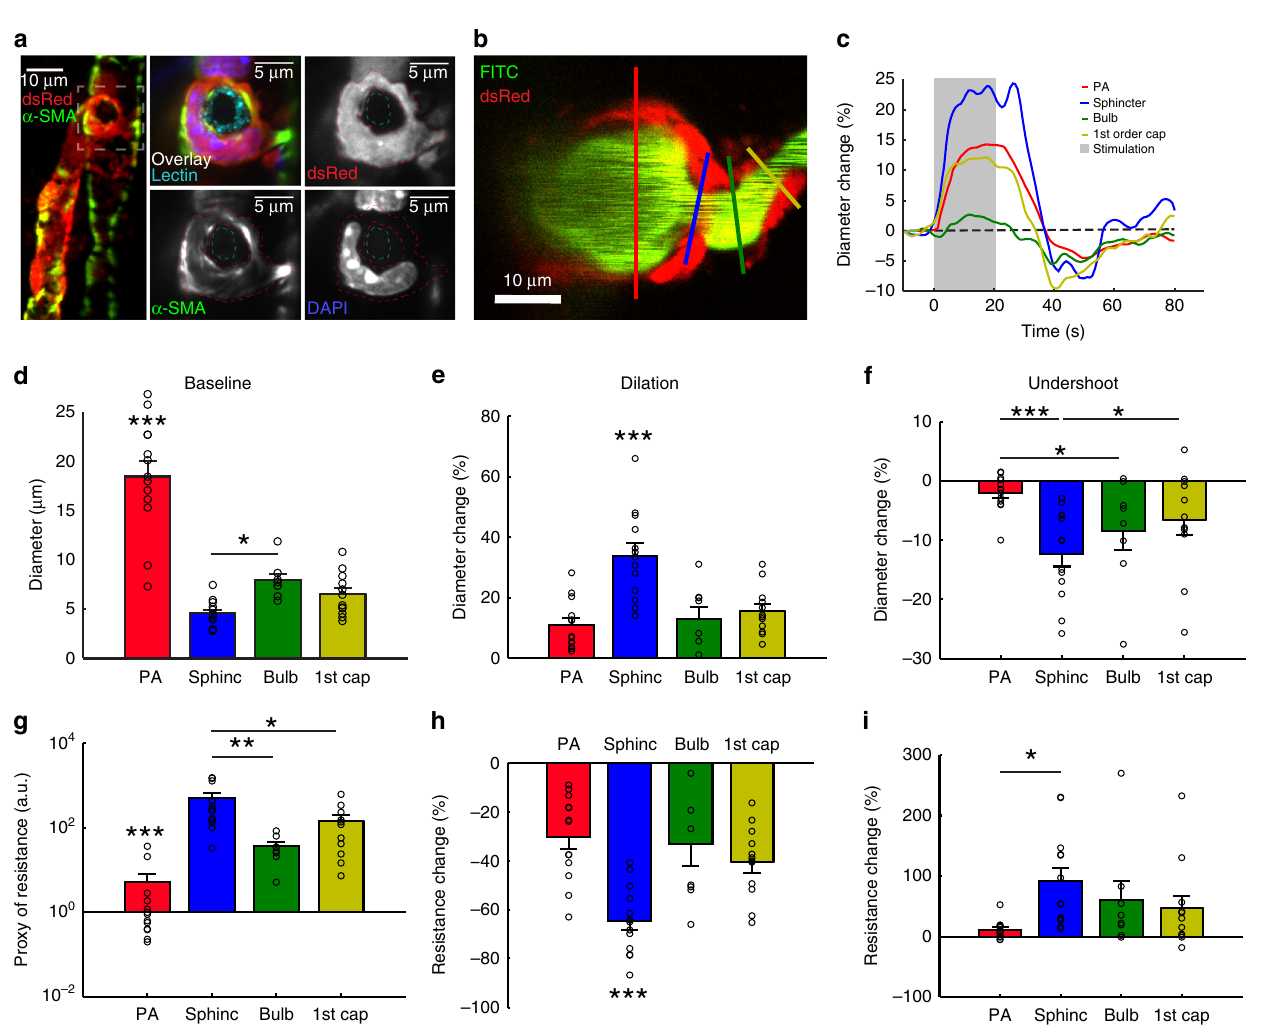
Fig. 3 Sphincters actively regulate blood fl ow. a Ex vivo coronal slices of an FITC-lectin-stained NG2-dsRed mouse immunostained for α -SMA. Left panel: maximal projection of a PA with a precapillary sphincter at the fi rst order capillary branch point. The marked area is shown on the right. Right panels: local maximal intensity projections of the precapillary sphincter region of dsRed, α -SMA, DAPI, or all channels including FITC-lectin overlaid. The lumen (cyan) and the outlines of the dsRed signal of the precapillary sphincter cell have been marked by dashed lines in the three grayscale images. b – i In vivo whisker pad stimulation experiments (anaesthetized NG2-dsRed mice) using maximal intensity projected 4D data obtained by two-photon microscopy, n = 13 mice for PA and sphincter, 8 for bulb and 12 for fi rst order capillary, ±SEM. b Maximal intensity projection of a PA branch point where the colored lines